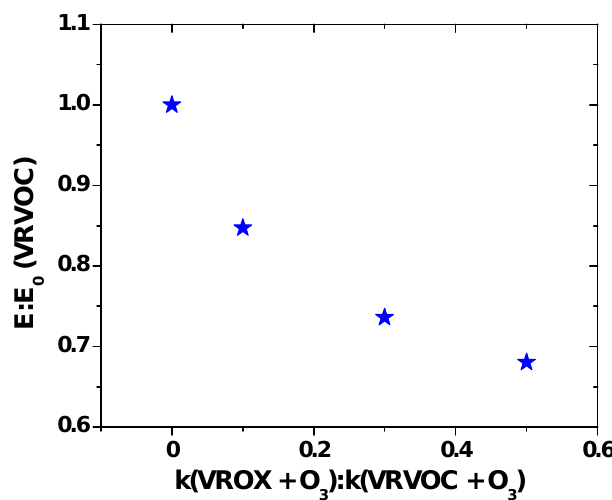
Fig. 7. Relative VRVOC emission rates required to reproduce ob- served non-stomatal ozone fluxes as a function of the rate constant for reaction of ozone with VROX (relative to that for reaction with VRVOC). See Sect. 3.6.3 for